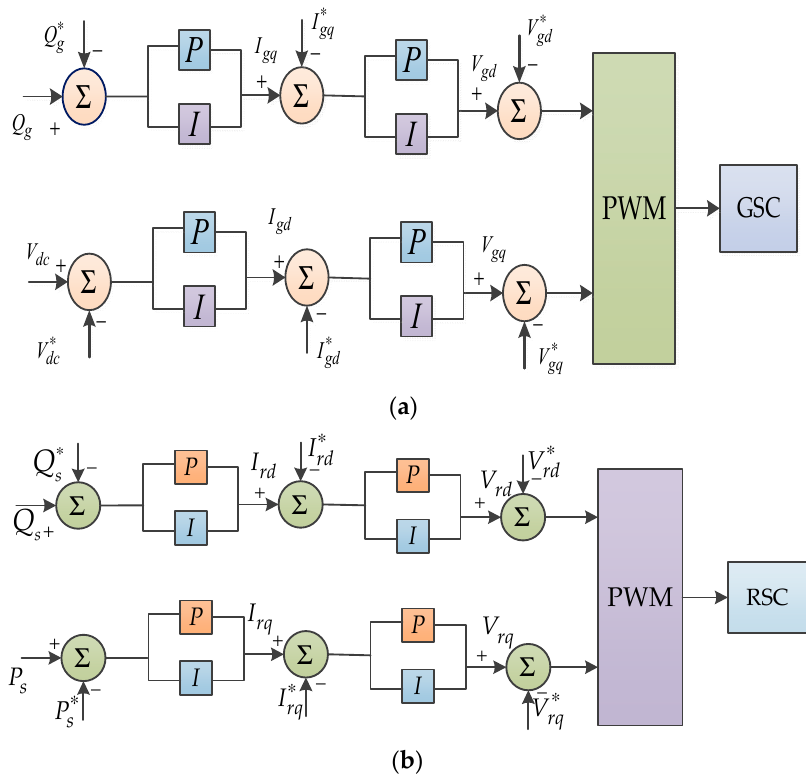
Figure 2. ( a ) Conventional proportional-integral (PI) control block diagram of GSC; ( b ) Conventional PI control block diagram of rotor side converter (RSC).